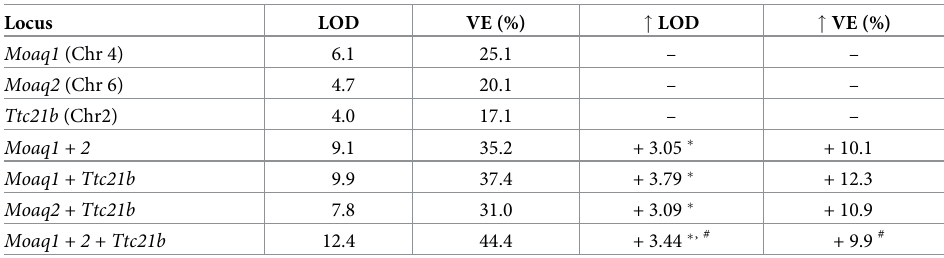
Table 2. Summary of QTL